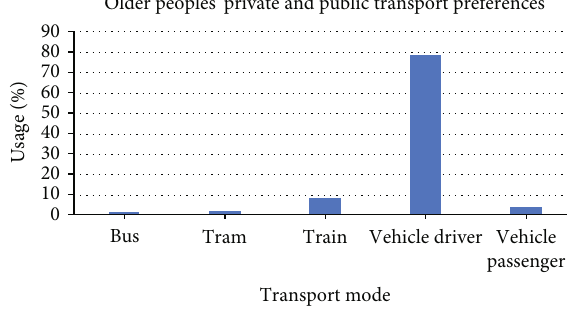
Figure 6: Older peoples ’ public and private transport mode